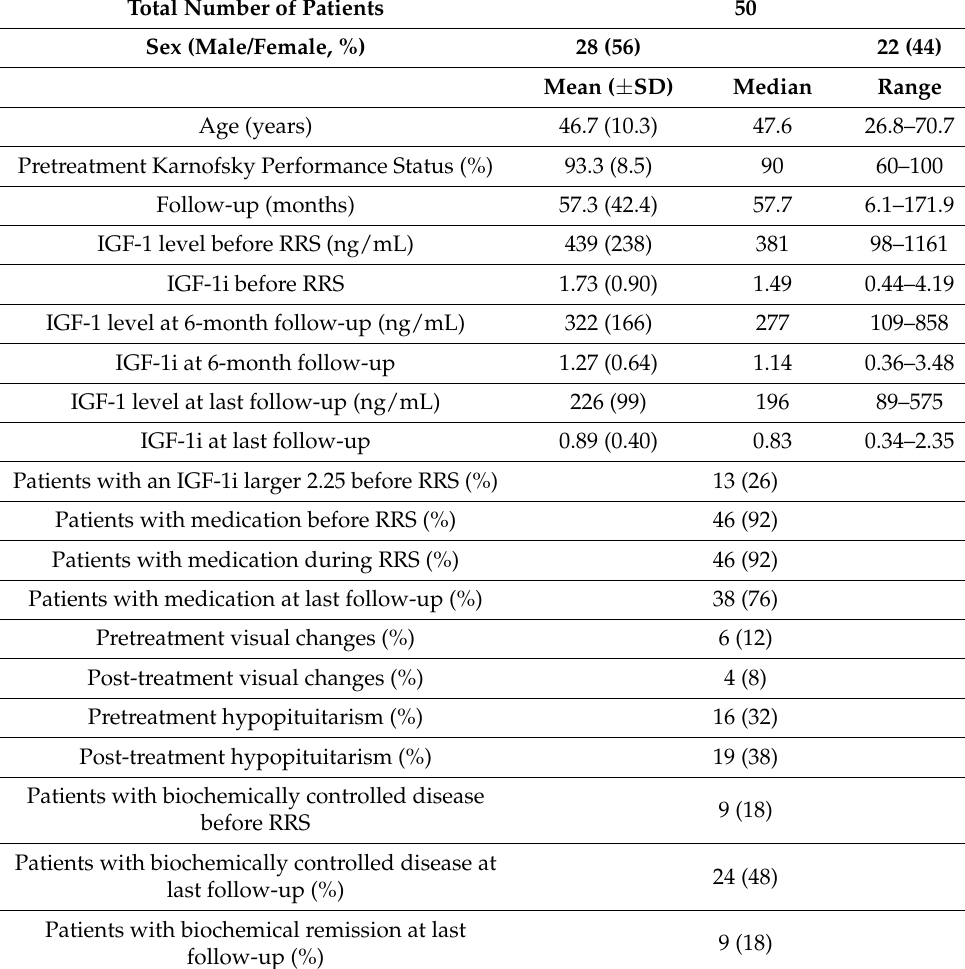
Table 1. Patient